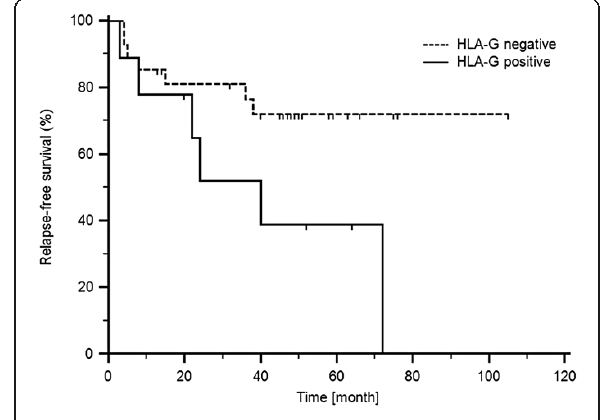
Figure 1 Comparison of HLA-G expression levels in RCC tissue and non-tumoral renal parenchyma (p=0.0058, Mann – Whitney test).